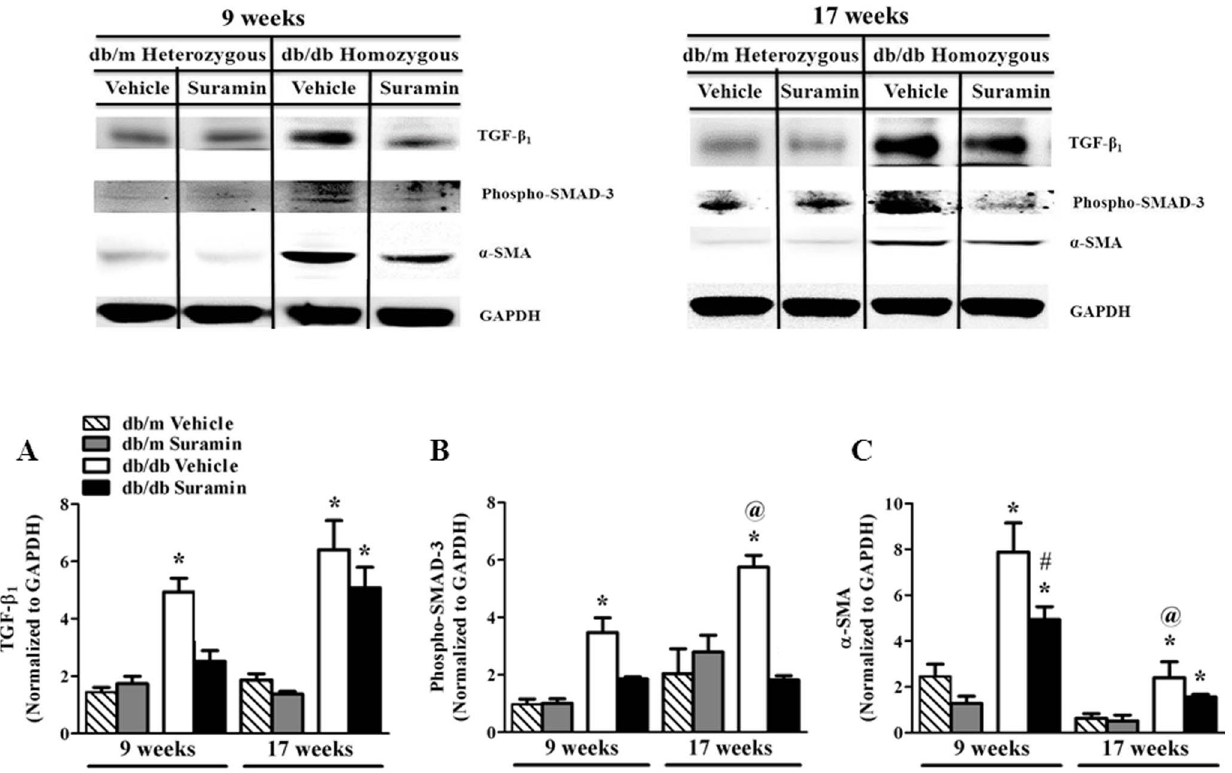
Figure 4. Effect of delayed administration of suramin on renal pro-fibrotic markers in 9/17 week db/db mice. Mice were treated as described in Figure 1. Representative Western blots showing profibrotic markers: Renal TGF- b 1 , renal phospho-Smad-3 and a -SMA in kidneys of 9/17 week db/db mice 6 suramin intervention. ( A ) Densitometric analysis of renal TGF- b 1 ; ( B ) Renal phospho-Smad-3; and ( C ) Renal a -SMA. Data were normalized by GAPDH which served as internal control. Data are expressed as mean 6 SE (n=4). * Significantly different from respective non-diabetic db/m mice ( p # 0.05). # Significantly different from vehicle-treated diabetic db/db mice ( p # 0.05). @ Significantly different from vehicle-treated 9 week diabetic db/db mice ( p #